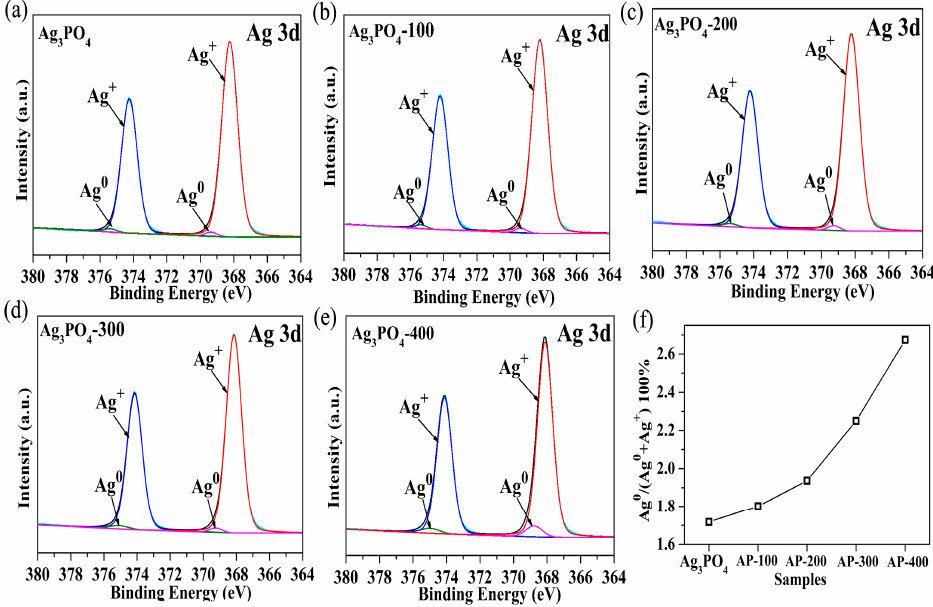
Figure 5. High-resolution XPS spectra of Ag 3d region of pristine Ag 3 PO 4 ( a ); and Ag 3 PO 4 -T (T = 100, 200, 300 and 400) ( b – e ); and the ratios of peak area attributed to Ag 0 to the total area of all Ag3d peaks for these samples ( f ) (AP denotes Ag 3 PO 4 in ( f )).